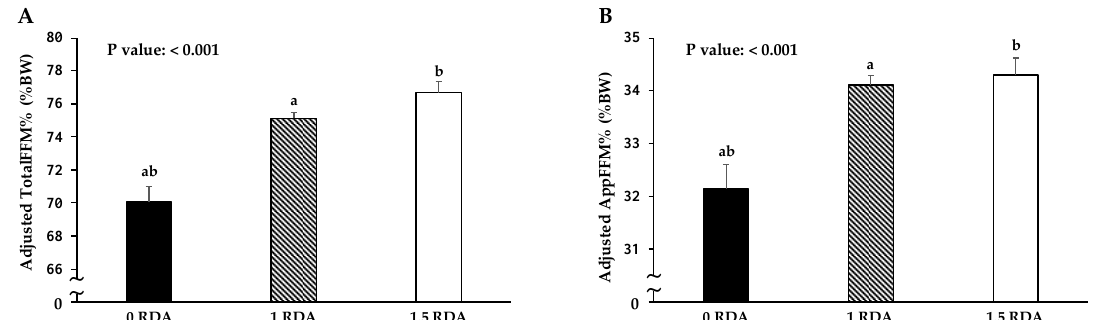
Figure 2. Comparisons of adjusted body compositions among the three groups ( ■ : 0 RDA group, <0.9 g/kg BW, n = 30; ▧ : 1 RDA group, 0.9–1.34 g/kg BW, n = 174; ☐ : 1.5 RDA group, ≥ 1.35 g/kg BW/day of total protein intake, n = 62) in ( A ) adjusted TotalFFM% and ( B ) adjusted AppFFM%. Values are expressed as means ± SE, and adjusted for age, sex, drinking habit, smoking habit, living condition